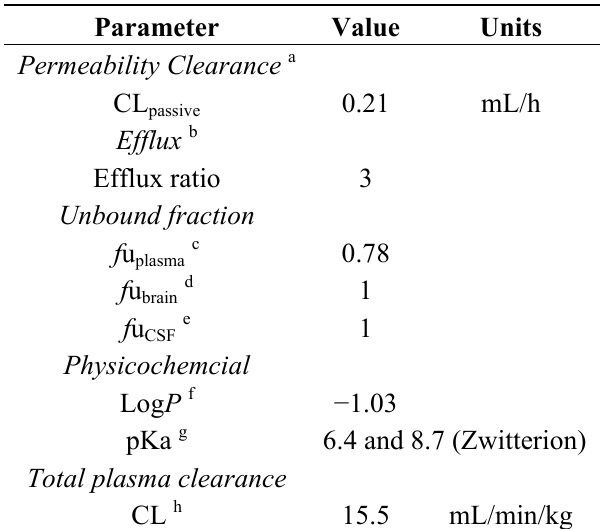
Table S1. Model input